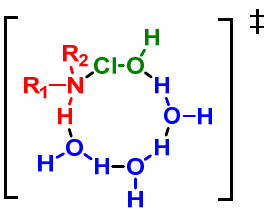
Figure 20. Transition state of the amine chlorination reaction.